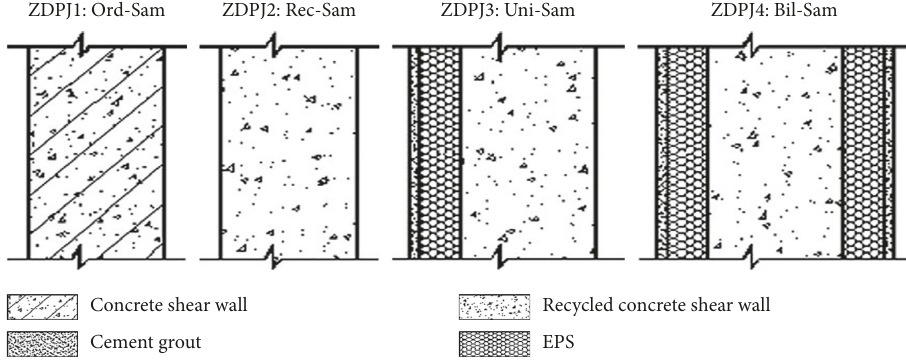
Figure 1: Four shear wall samples with different types.